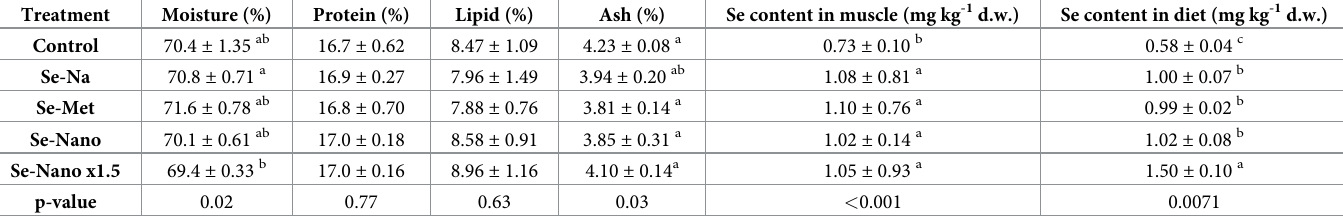
Table 3. Carcass composition (muscle) of Nile tilapia ( Oreochromis niloticus ) fed with different dietary selenium sources over a 60-day period and analyzed sele- nium content of experimental diets. Treatment